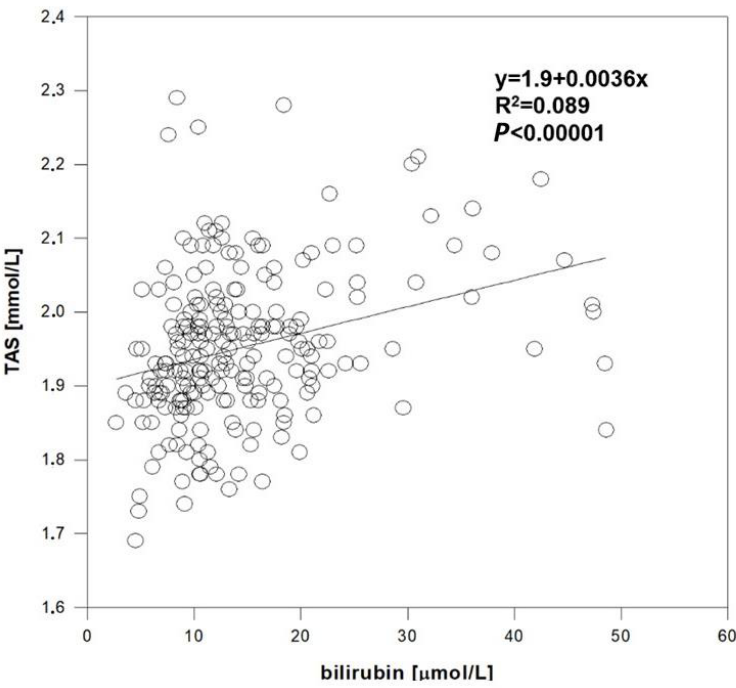
Figure 2. Relationship between serum bilirubin concentration and TAS in healthy controls.